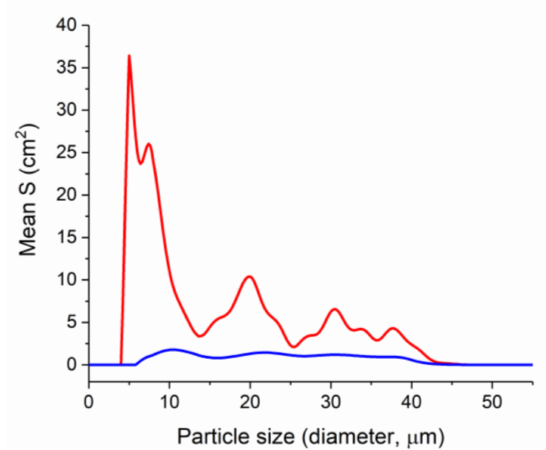
Figure 5. Comparison of the mean total particle surface area of the control and the test solution of zinc methioninate depending on the particle size ( n = 3), red—control, blue—Zn(Met) 2 solution.